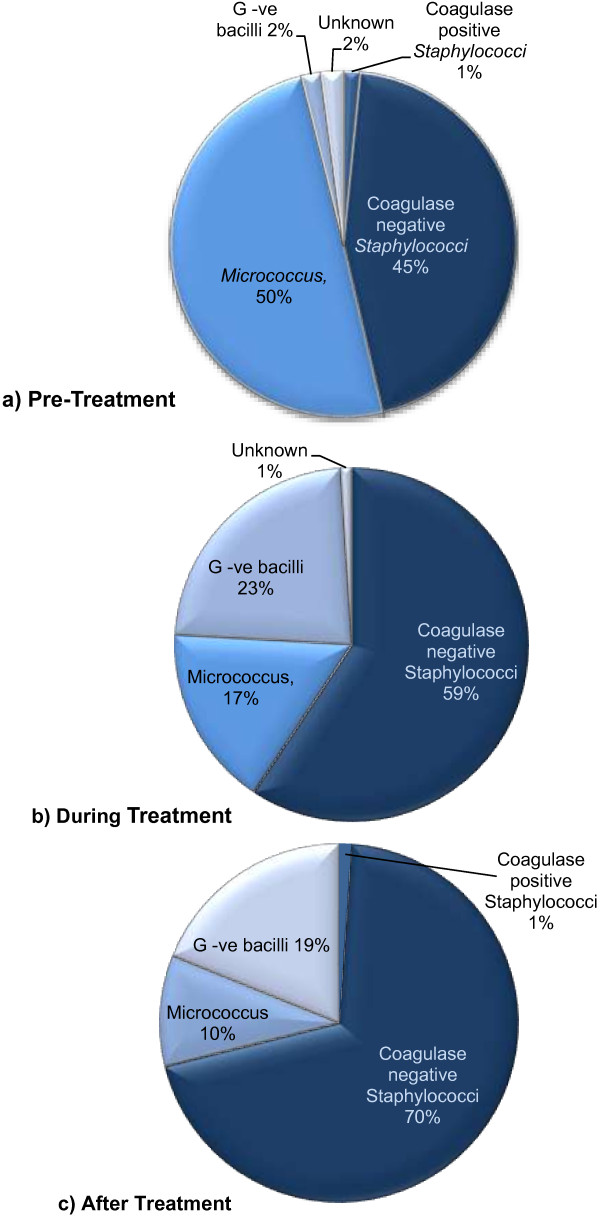
Characterisation of bacterial air contamination a) pre-treatment, b) during treatment and c) after treatment.